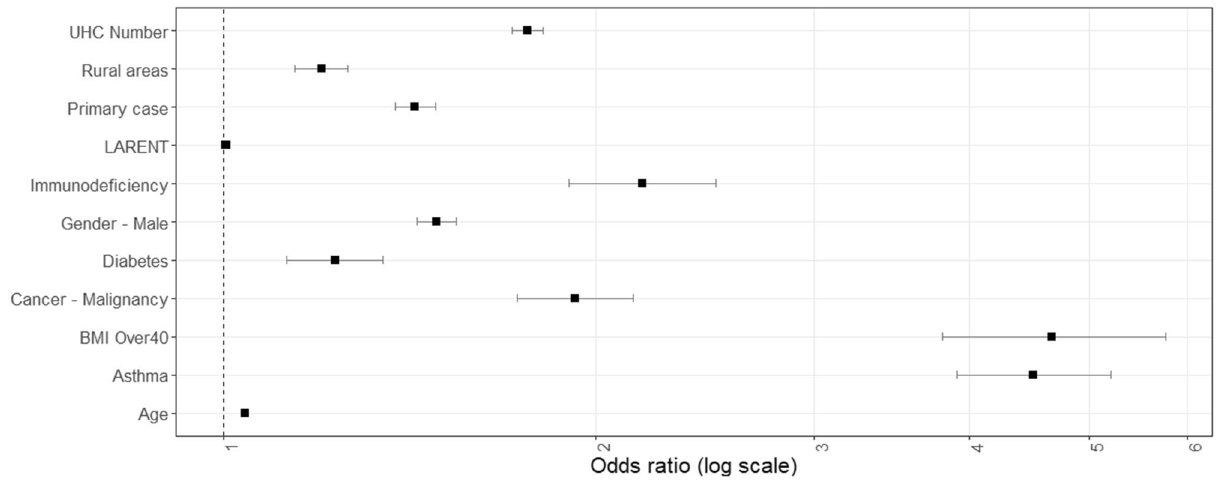
Figure 1. Forest plot of adjusted odds ratios for hospitalization from validated generalised linear